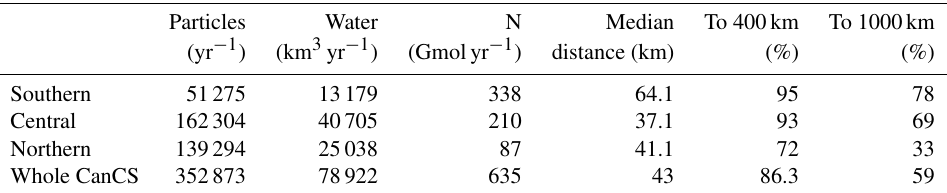
Table 1. The annual number of upwelling particles and their associated water and nitrogen, the median distance of upwelling to the coast and the net transport of water to 400 and 1000km from coast (as percent of upwelling volume) in the three subregions as well as the entire CanCS region in our experiment.